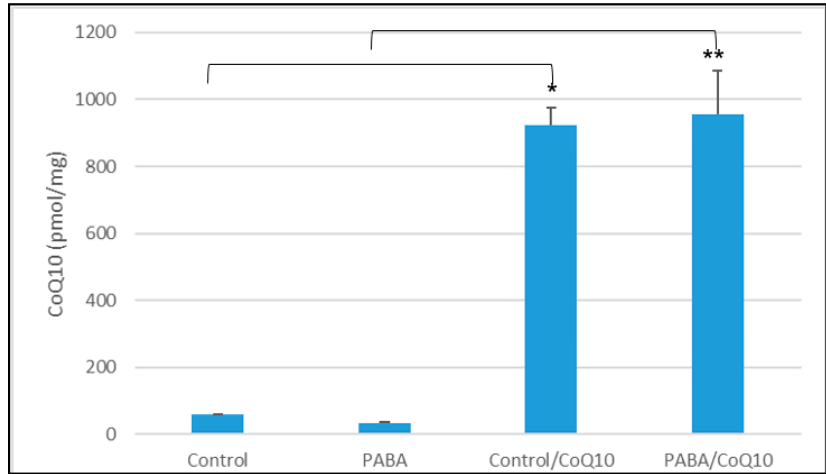
Figure 3. The cellular CoQ 10 concentration, after treatment with 5 µ M CoQ 10 over 3 days. Figure shows concentration of CoQ 10 after PABA treatment and subsequent CoQ 10 treatment. CoQ 10 concentration standardised to protein baseline (mg of protein). Comparison of groups was carried out as follows: control group vs. PABA, Control group vs. Control CoQ 10 treated, PABA group vs. PABA CoQ 10 treated. Data available in supplemental data under Table S3. Level of significance * p < 0.05, ** p < 0.05; n =